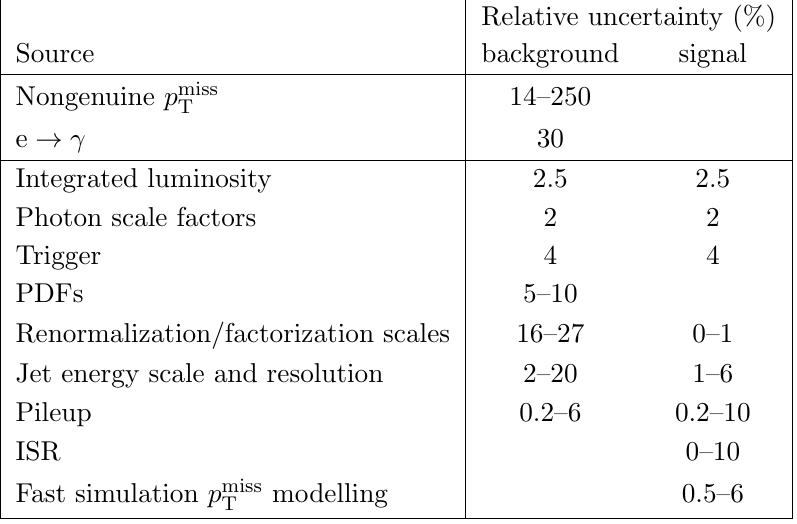
Table 2 . Systematic uncertainties for background determined from control samples in data ((cid:12)rst two rows) and simulation (all other rows). If two values are given, the (cid:12)rst one is for simulated SM backgrounds, while the latter is for simulated signal. The PDF and scale uncertainties for the signal simulation a(cid:11)ect the shape only, as the uncertainty in the rate is already considered in the overall cross section uncertainty